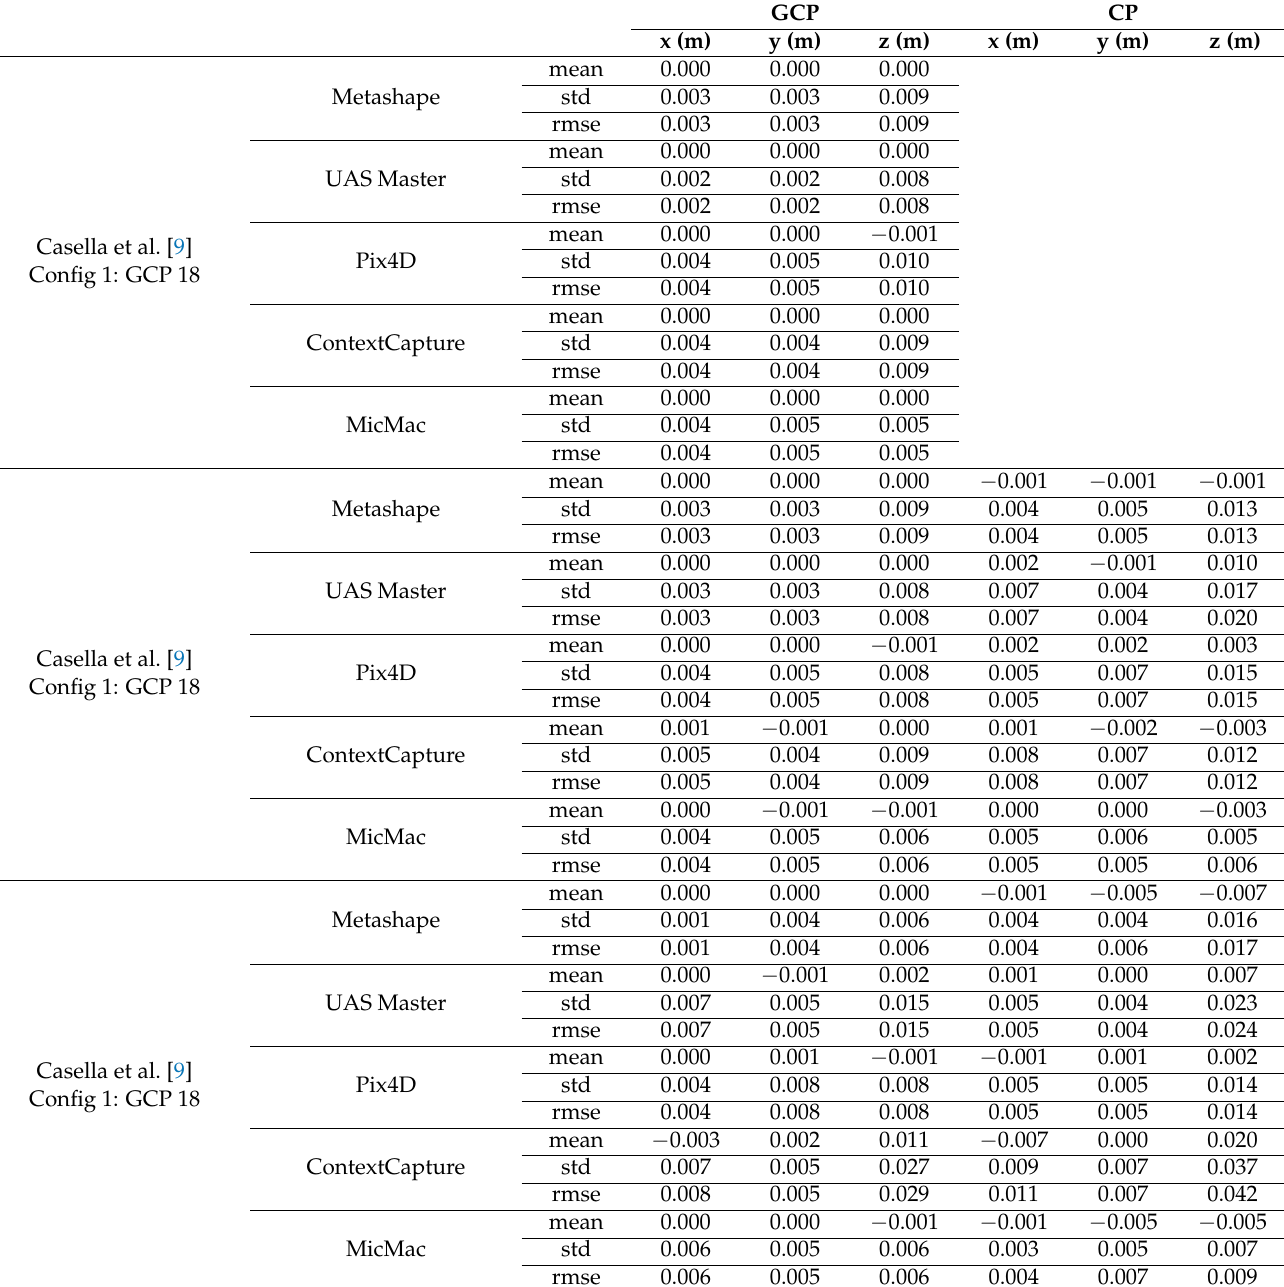
Table 1. Results obtained from the different software tested. Adapted from